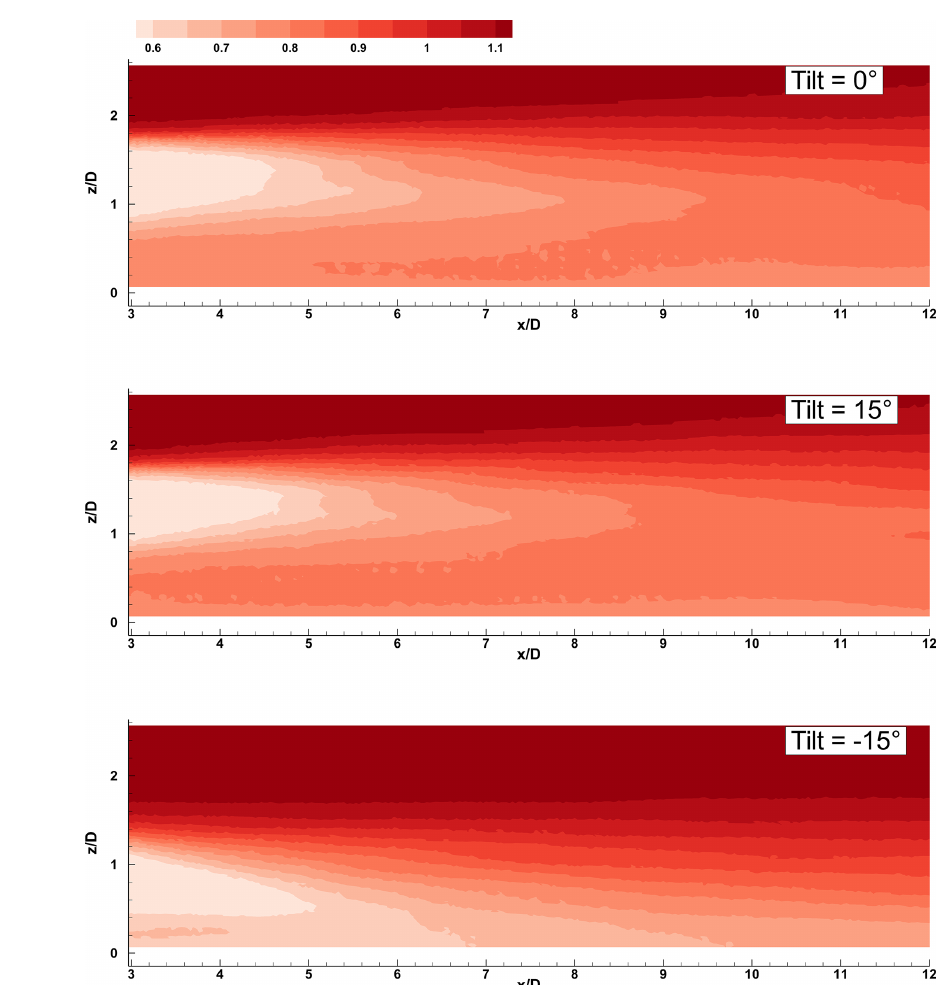
Figure 6. Contours of normalized streamwise velocity u/U hub on the xz longitudinal midplane for three rotor tilt angles.